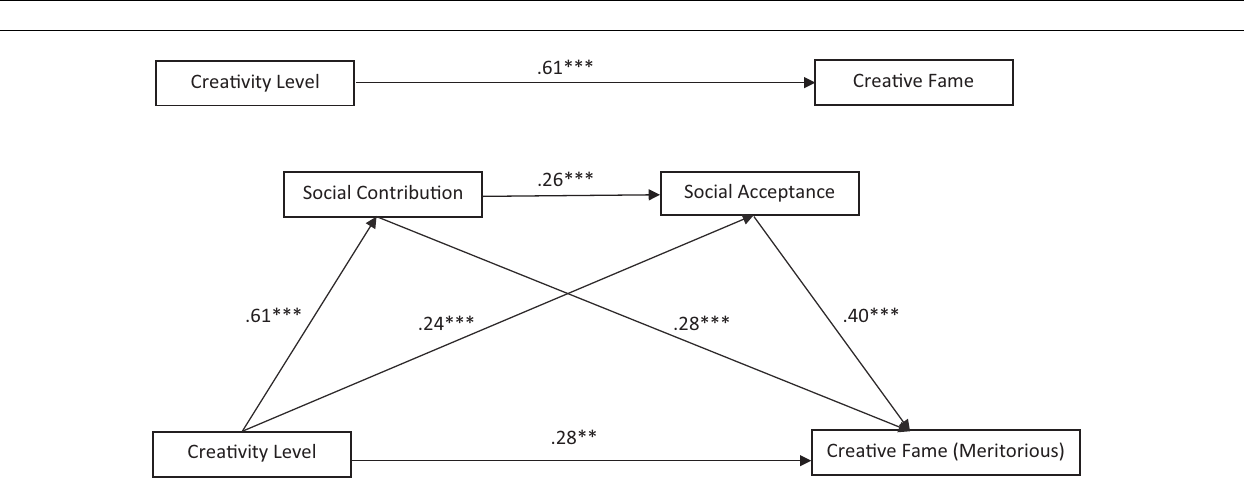
FIGURE 4 | Three-path mediation model between creativity, SC, SA and creative fame: meritorious areas. ∗∗ p < 0.01, ∗∗∗ p < 0.001